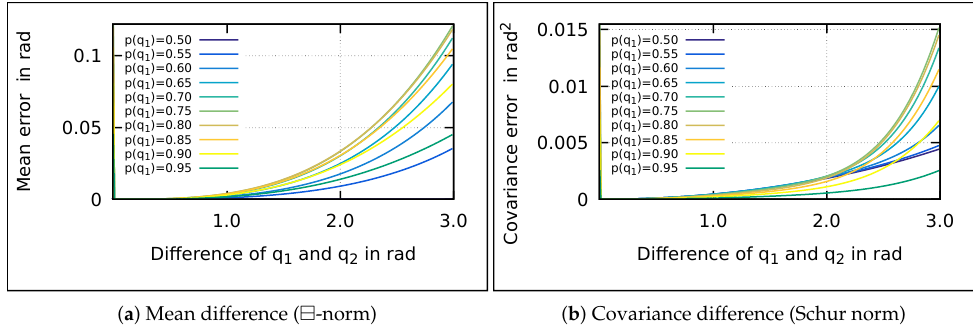
Figure 3. The mean and covariance difference between (cid:1) - and naive-mixing over the angular differences of q 1 and q 2 . Reprinted with permission from ref. [22]. Copyright 2020